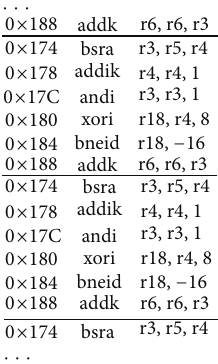
F 1: Example of a repeating pattern of instructions in the trace of a 8-bit count